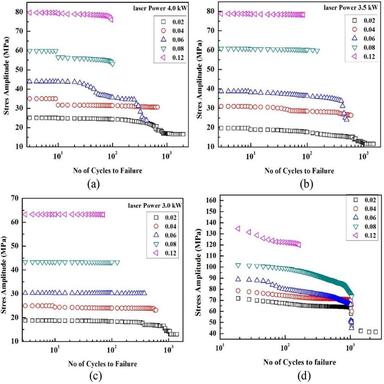
Stress amplitude vs. no. of cycles to failure with varying laser powers: (a) 4 kW, (b) 3.5 kW, (c) 3.0 kW, (d) base material (AA6082).